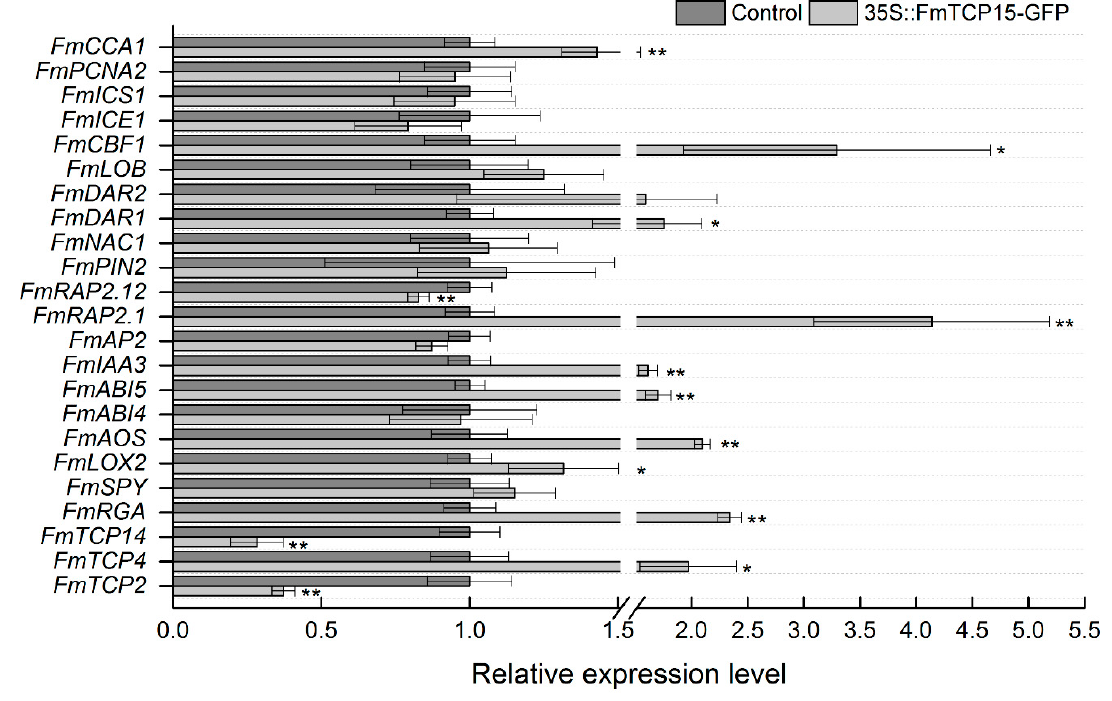
Figure 5. Quantitative assay results for downstream genes of transient overexpression of FmTCP15 seedlings. The expression profile data of downstream genes of FmTCP15 were obtained through qRT-PCR. * Indicates a significant difference between control and 35S::FmTCP15-GFP ( p < 0.05). ** Indicates a highly significant difference between control and 35S::FmTCP15-GFP ( p < 0.01) according to Duncan’s multiple range test.